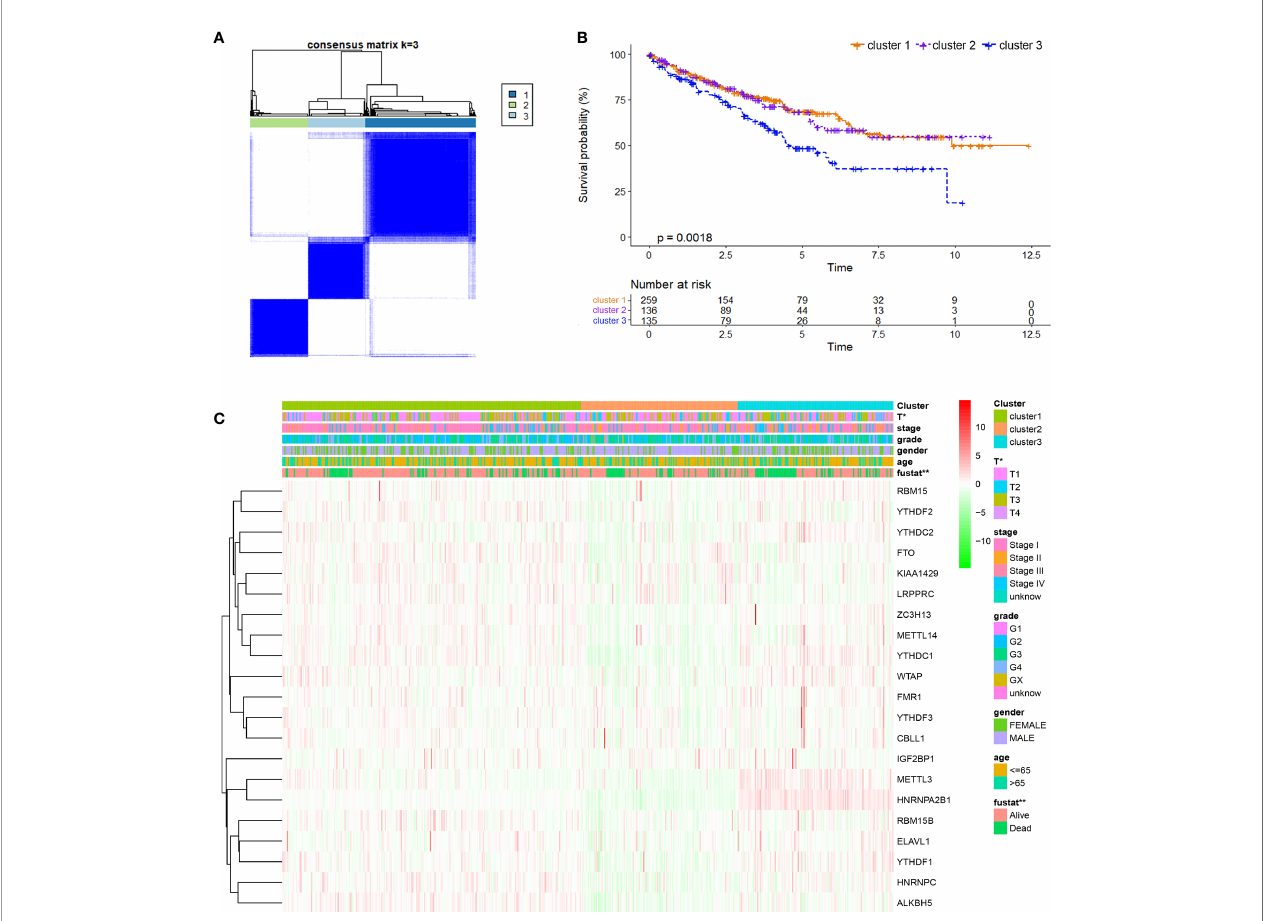
FIGURE 3 | Identi fi cation and comparison of various m6A modi fi cation patterns of ccRCC. (A) By using ConsensusClusterPlus algorithm, ccRCC samples from TCGA cohort were automatically divided into three m 6 A modi fi cation subclasses, clusters 1/2/3. (B) K – M method was implemented to assess prognostic value between clusters for ccRCC patients from TCGA. (C) A heatmap displaying clinico-pathological implications of m 6 AMS and expression distributions of 21 m 6 A regulators (*p < 0.05, **p < 0.01).